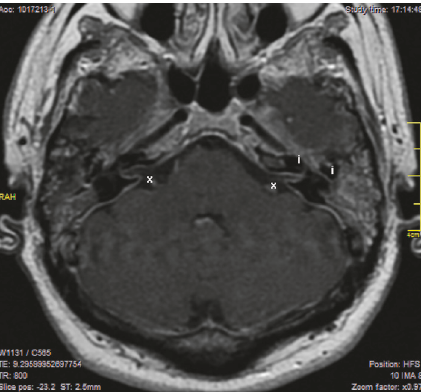
Figure 1: T1-weighted Gd-MRI, axial image . x: symmetrical lineal diffuse thickening and enhancement of the dural layer of the IAC. i: left labyrinthine and tympanic facial nerve enhancement.